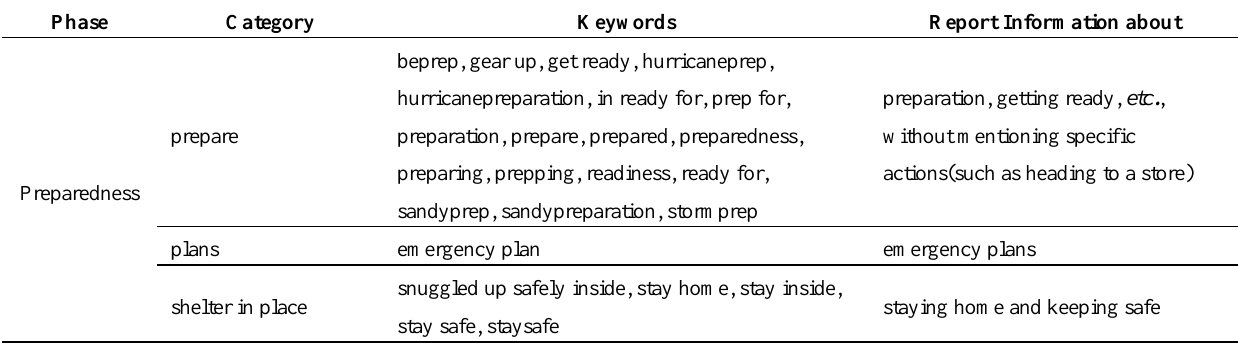
Table 1. Tweet classes and keywords during different disaster